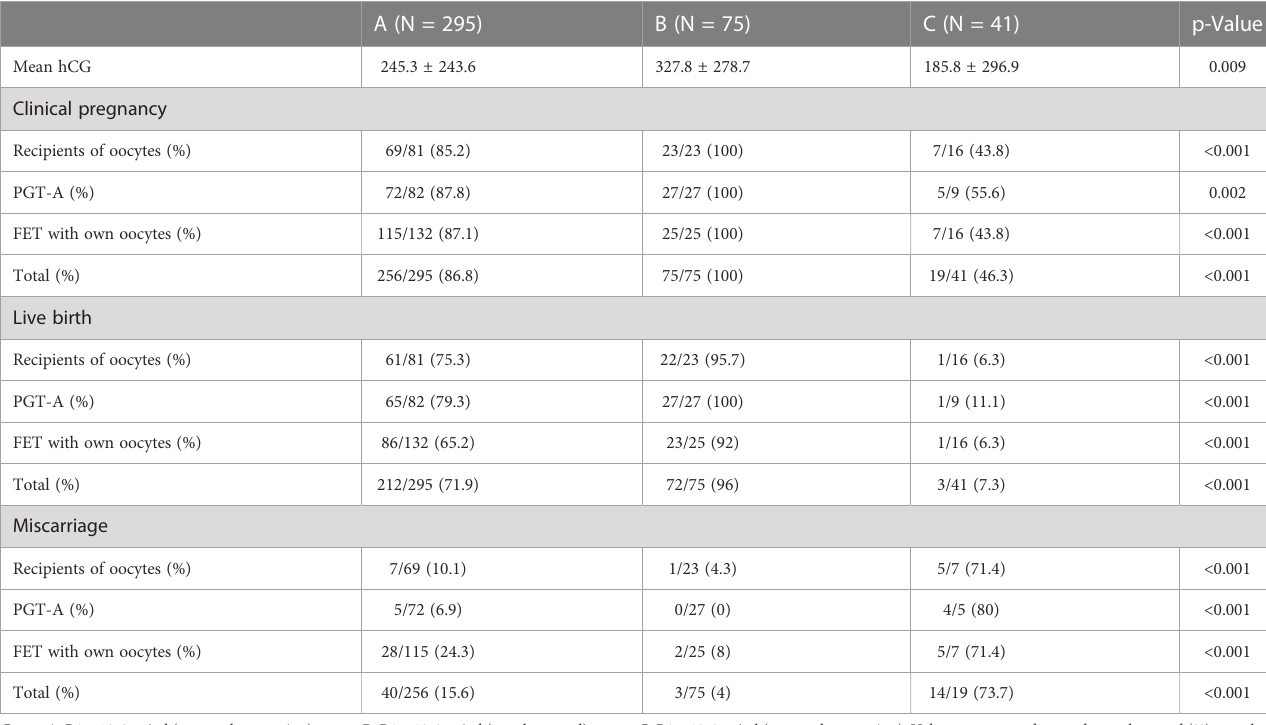
TABLE 4 Clinical outcomes per group of progesterone and supplementation or not analyzed for all the pregnancies considered with hCG ≥ 10